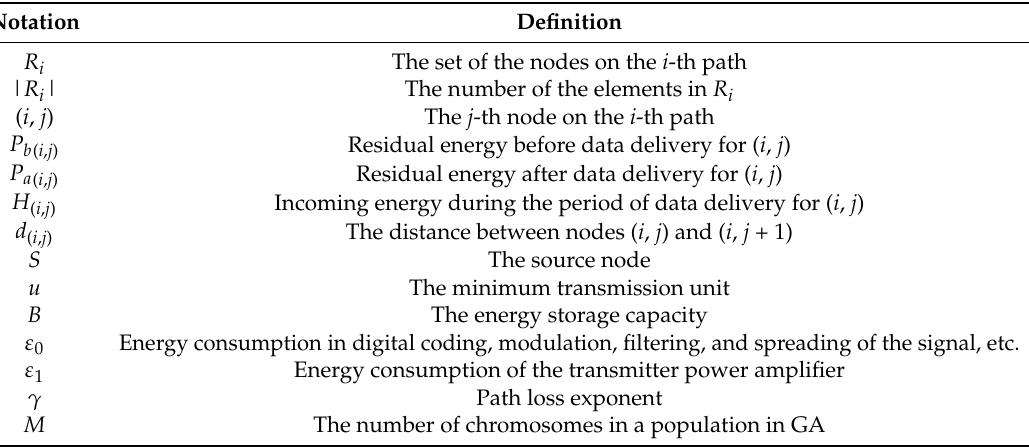
Table 1. Definitions of notations